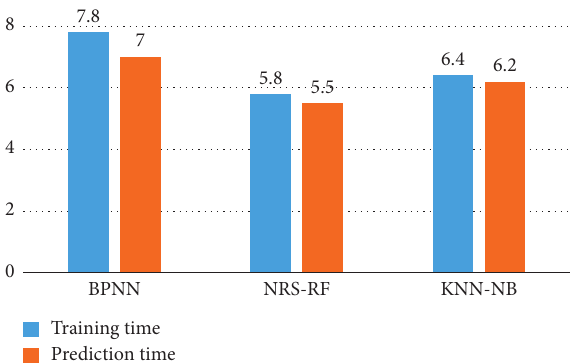
Figure 11: Comparison of training time and prediction time in different models.